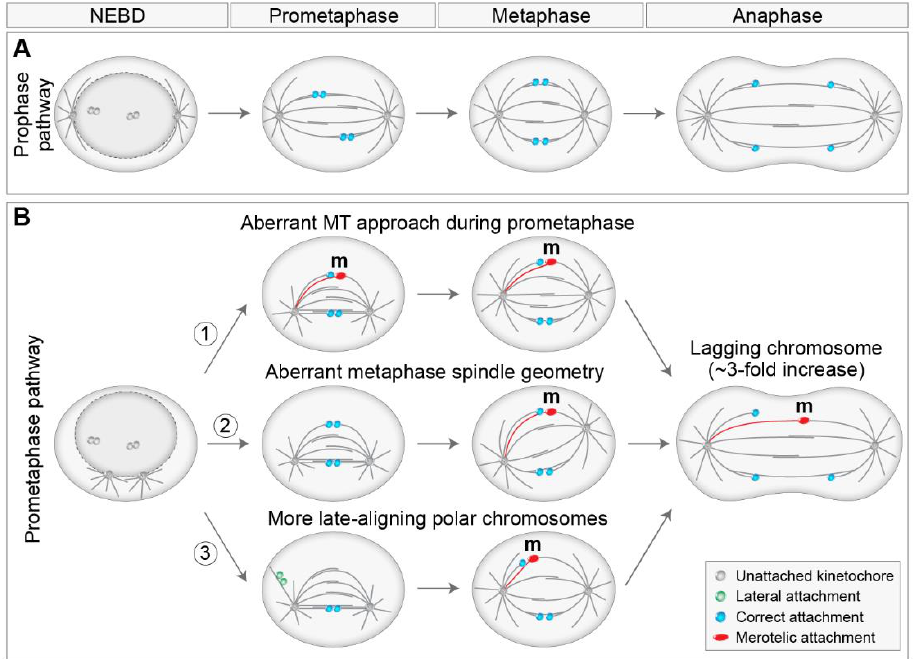
Figure 5. Models by which the degree of centrosome separation upon nuclear envelope breakdown (NEBD) influences the fidelity of chromosome segregation. ( A ) Two spindle poles separate before NEBD, termed the prophase pathway. This pathway is not characterized by chromosome mis-segregation. ( B ) Spindle poles separate after NEBD, termed the prometaphase pathway. The prometaphase pathway is associated with a three-fold increase in the number of lagging chromo- somes compared to the prophase pathway through different mechanisms that promote erroneous merotelic attachments (1)–(3). An erroneous microtubule from the distal pole connected to a merotelic kinetochore is labeled red. The arrows indicate changes over time. Kinetochores with different attachment types are color labeled according to the legend on the bottom right. MT, microtubule; m, merotelic attachment.